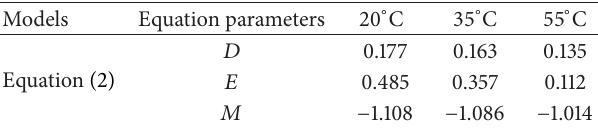
Table 4: Models fitting results for selected breakthrough curves